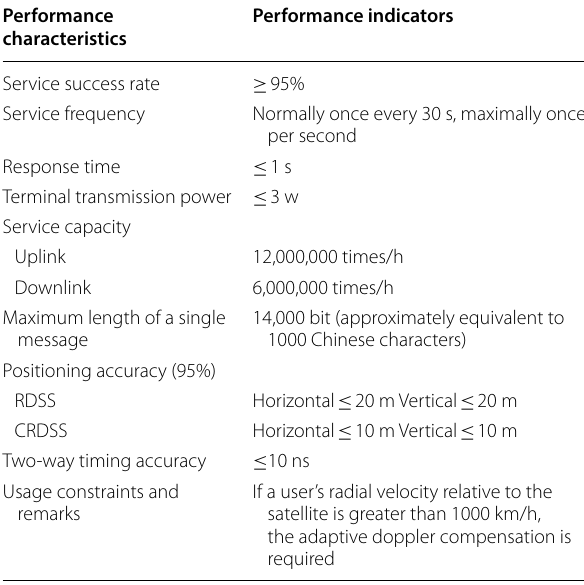
Table 5 Main BDS International SAR Service